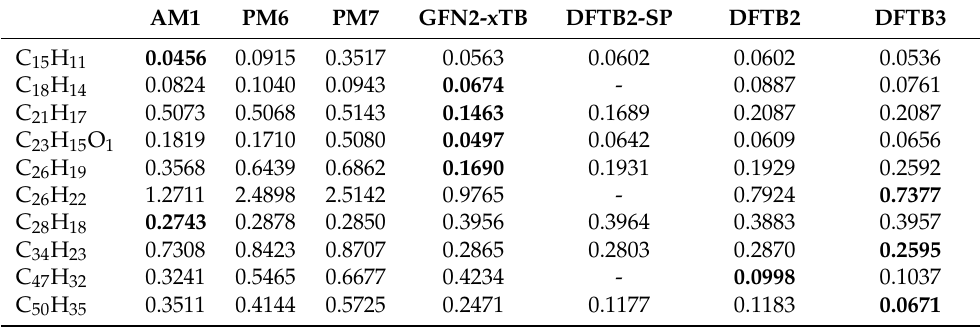
Table 1. The 10 soot molecules were extracted from molecular dynamic trajectories, which were optimized using the M06-2x method as a reference structure, and the structures were optimized separately using various SE methods in the table after rotating and overlapping the coordinates using the Kabsch algorithm and calculating the RMSE of the structure optimized by each method and the reference structure. The smaller the RMSE value, the more similar the structure was optimized to the reference structure, the minimum value of this row is marked as bold. AM1